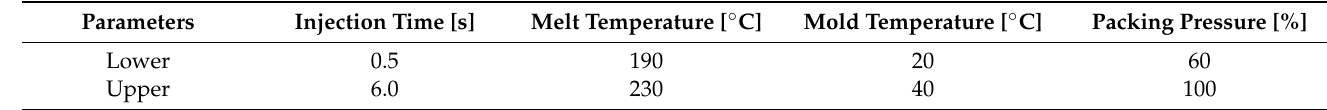
Table 8. Parameters’ limits for OLHS.